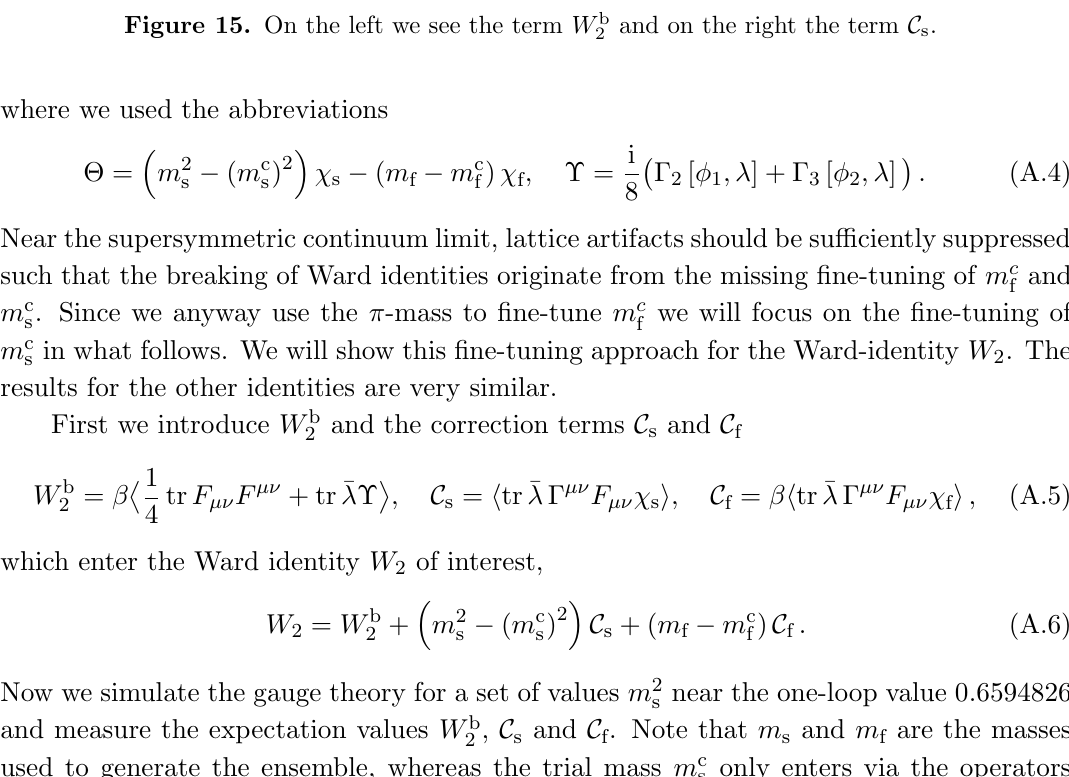
Figure 15. On the left we see the term W b